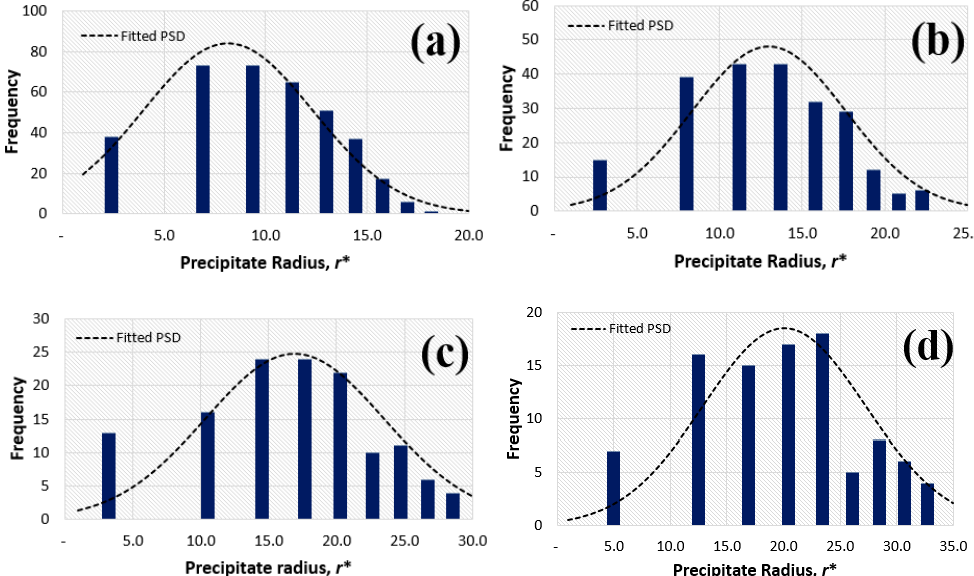
Figure 12. Histograms of the PSD in presence of 30% nanoparticles of size 20 at different times, t *, of: ( a ) 1000, ( b ) 2500, ( c ) 10,000 and ( d ) 20,000.